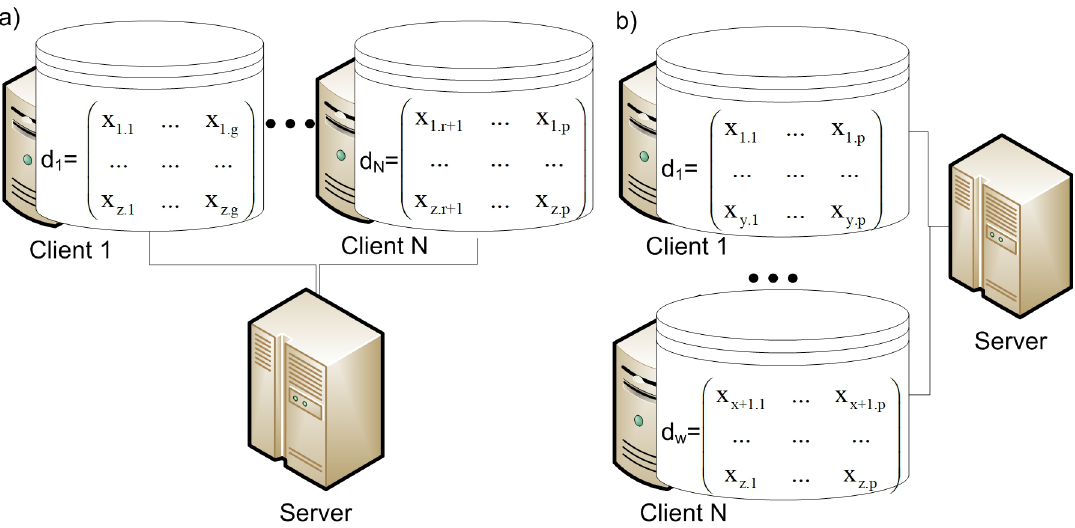
Figure 2. Data partitioning: ( a ) horizontal; ( b ) vertical.